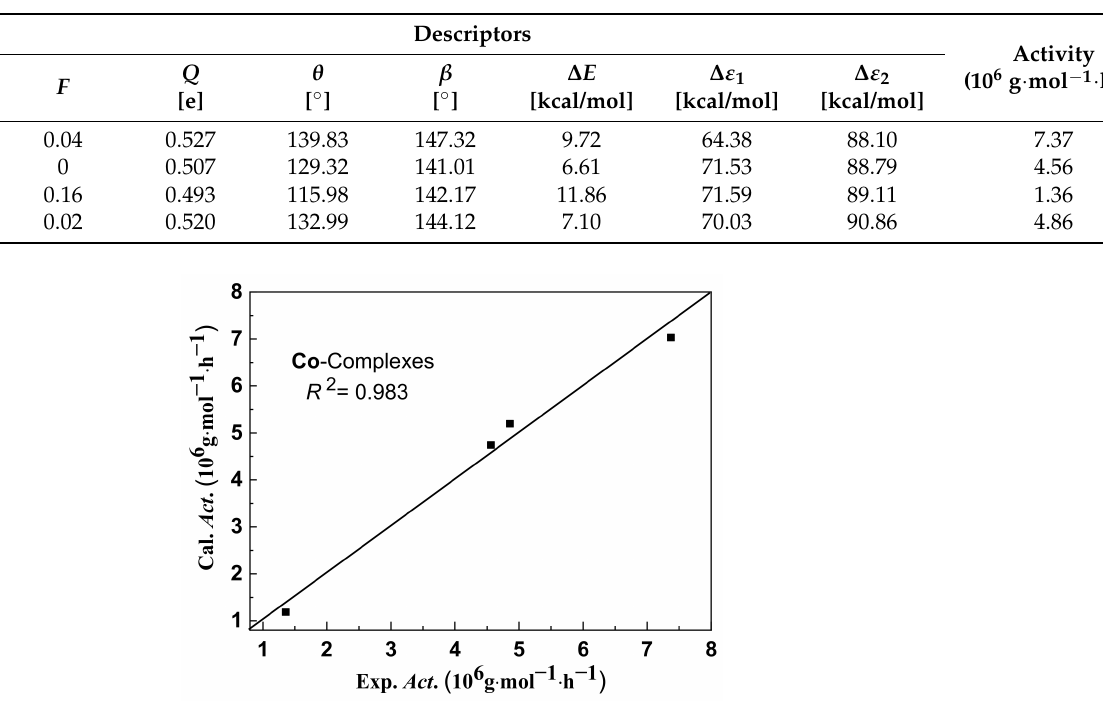
Table 5. The values of Hammett constant ( F ), effective net charge ( Q eff ), open cone angle ( θ ), bite angle ( β ), energy difference ( ∆ E ), and HOMO–LUMO energy gap ( ∆ ε 1, ∆ ε 2 ), together with experimental catalytic activities for Co complexes.